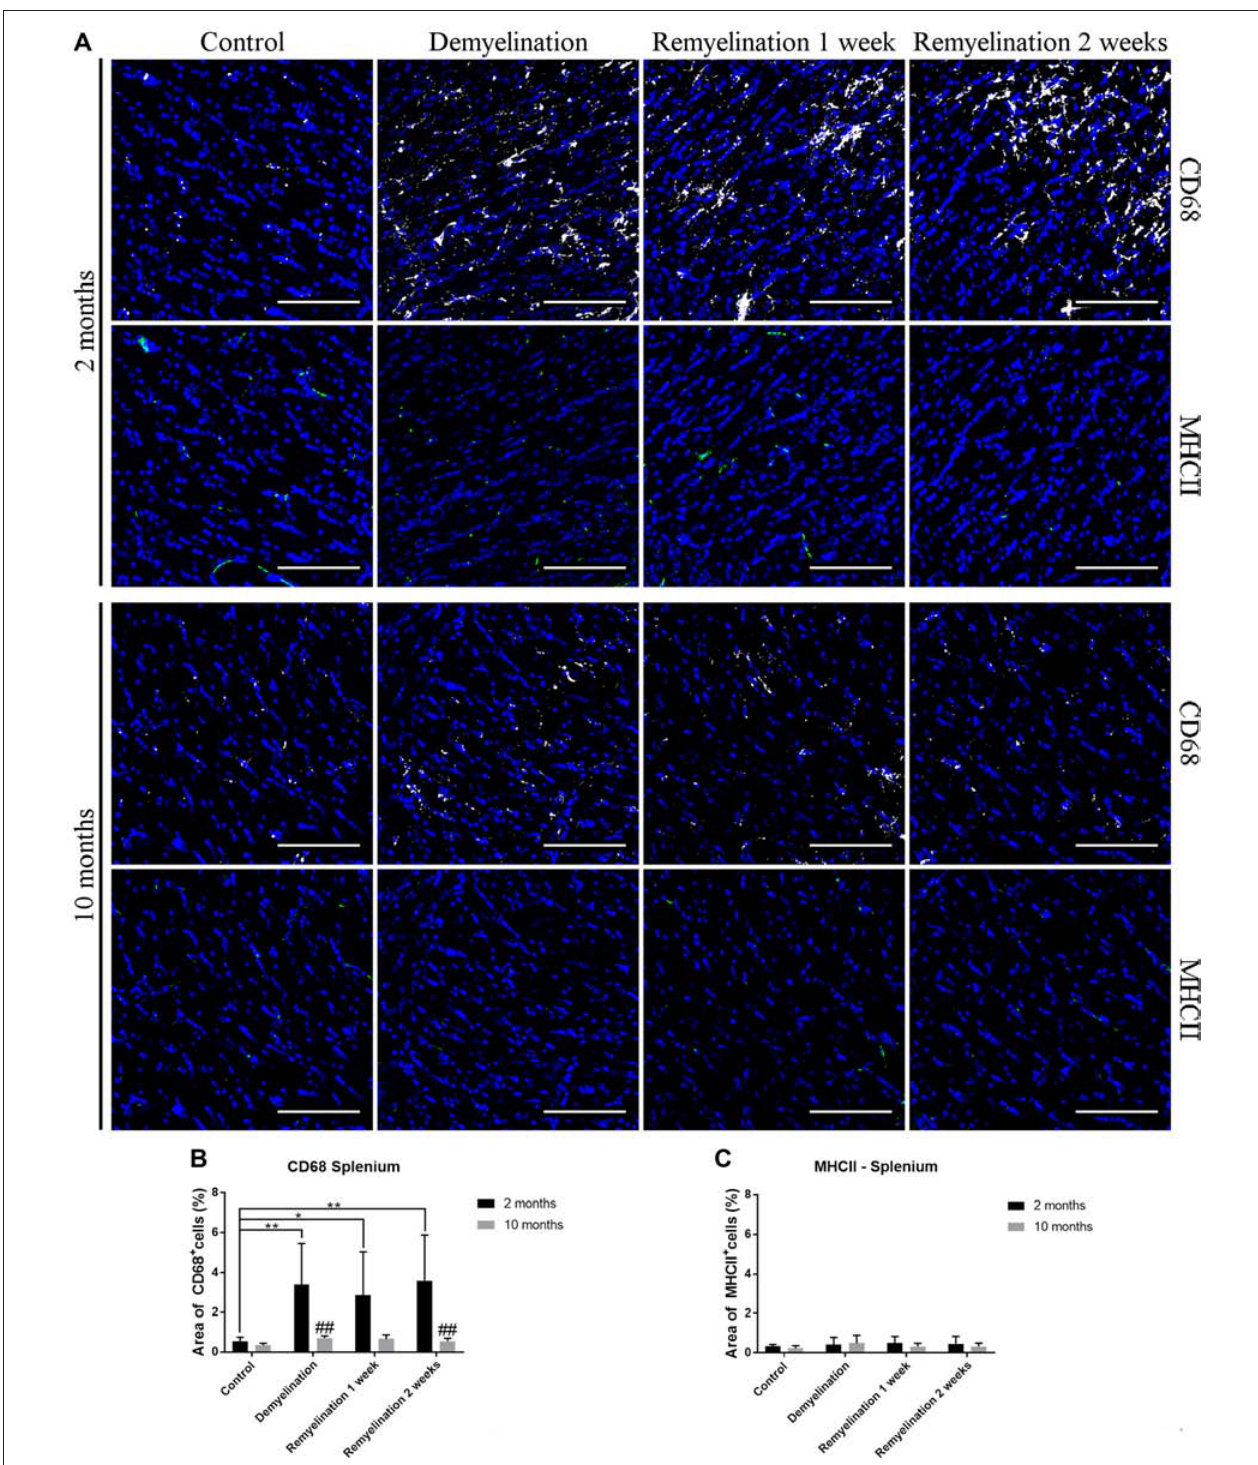
FIGURE 6 | Age-related differences in CD68, but not in MHCII, in splenium of the CC. (A) CD68 (white) and MHCII (green) labeling. Cell nuclei are stained with DAPI (blue). (B) CD68 was significantly increased during de- and remyelination only in the younger group leading to significant age-related differences (with higher values in the younger group) after demyelination and 2 weeks of remyelination. (C) MHCII staining was not significantly changed by de- or remyelination in both age groups. Values are shown as means + SD ( n = 6 per group). Statistical significance was evaluated using a two-way ANOVA followed by a Tukey’s post hoc test. The p -values are indicated in the graphs: treatment effects within the same age group: ∗ p < 0.05 and ∗∗ p < 0.01, age-related differences: ## p < 0.01. Bars: (A) 100 µ m.